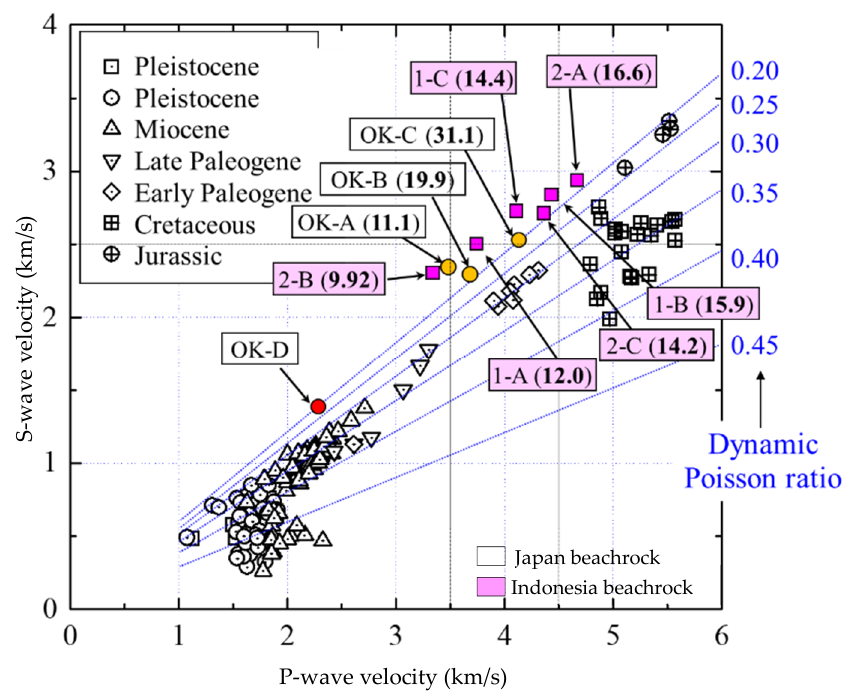
Figure 5. Comparison of the geophysical properties of the sedimentary rocks and beachrocks based on compressional wave (P-wave) velocity and shear wave (S-wave) velocity.